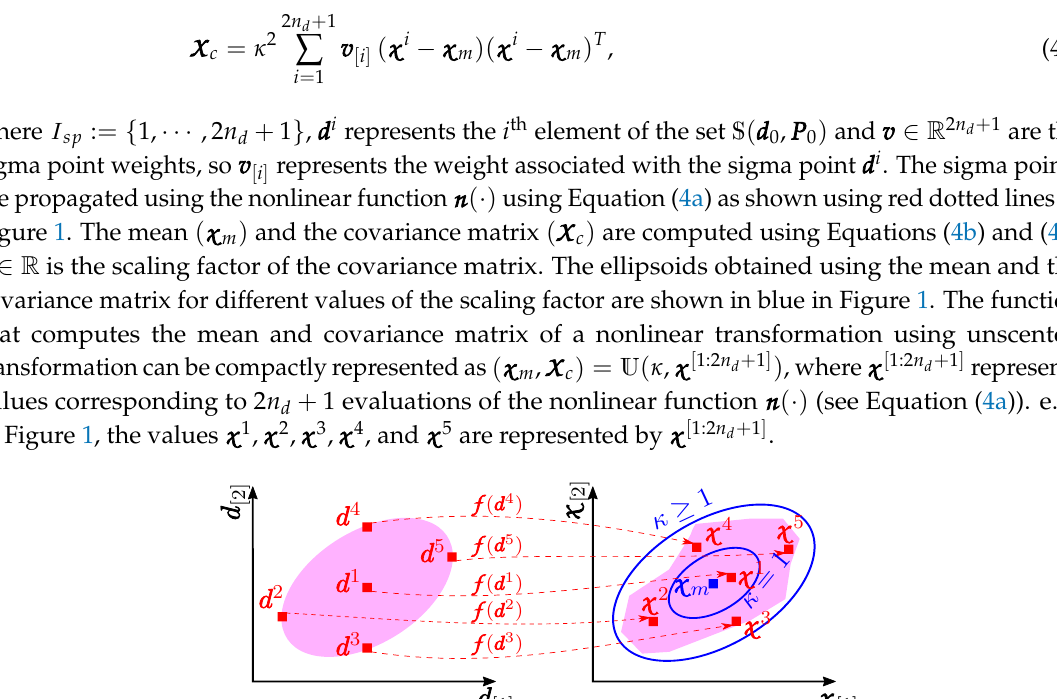
( b ) The image set of the nonlinear function n